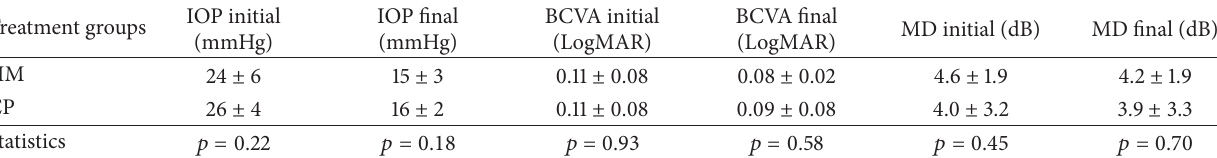
Table 1: Parameters considered for the study at the baseline (initial) and after a 24-month follow-up (final) for the two treatment groups. Treatment groups